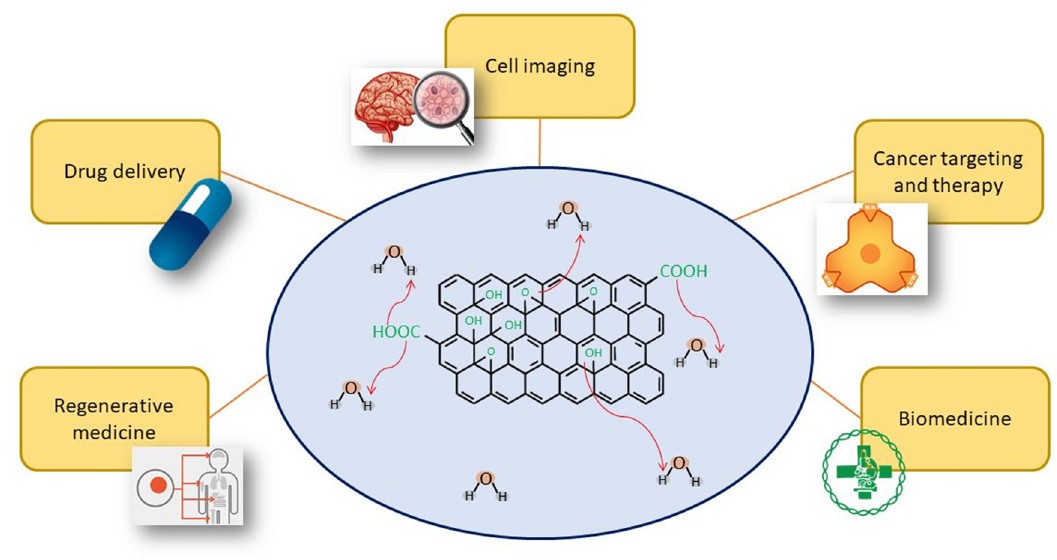
Figure 1: Utilization of graphene in di ff erent fi elds of